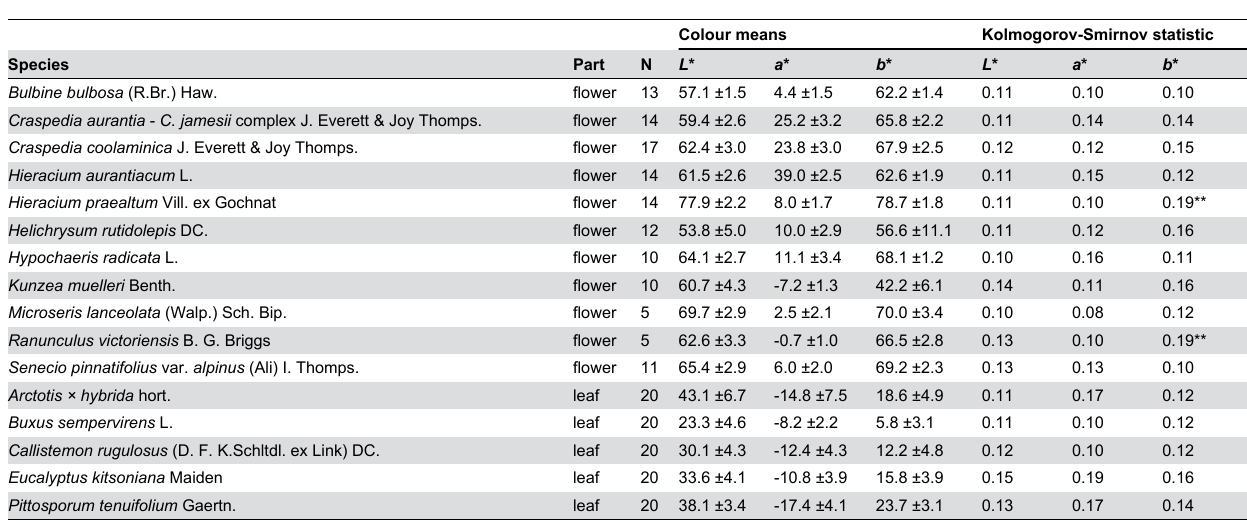
Table 1. Summary statistics for species measured in this